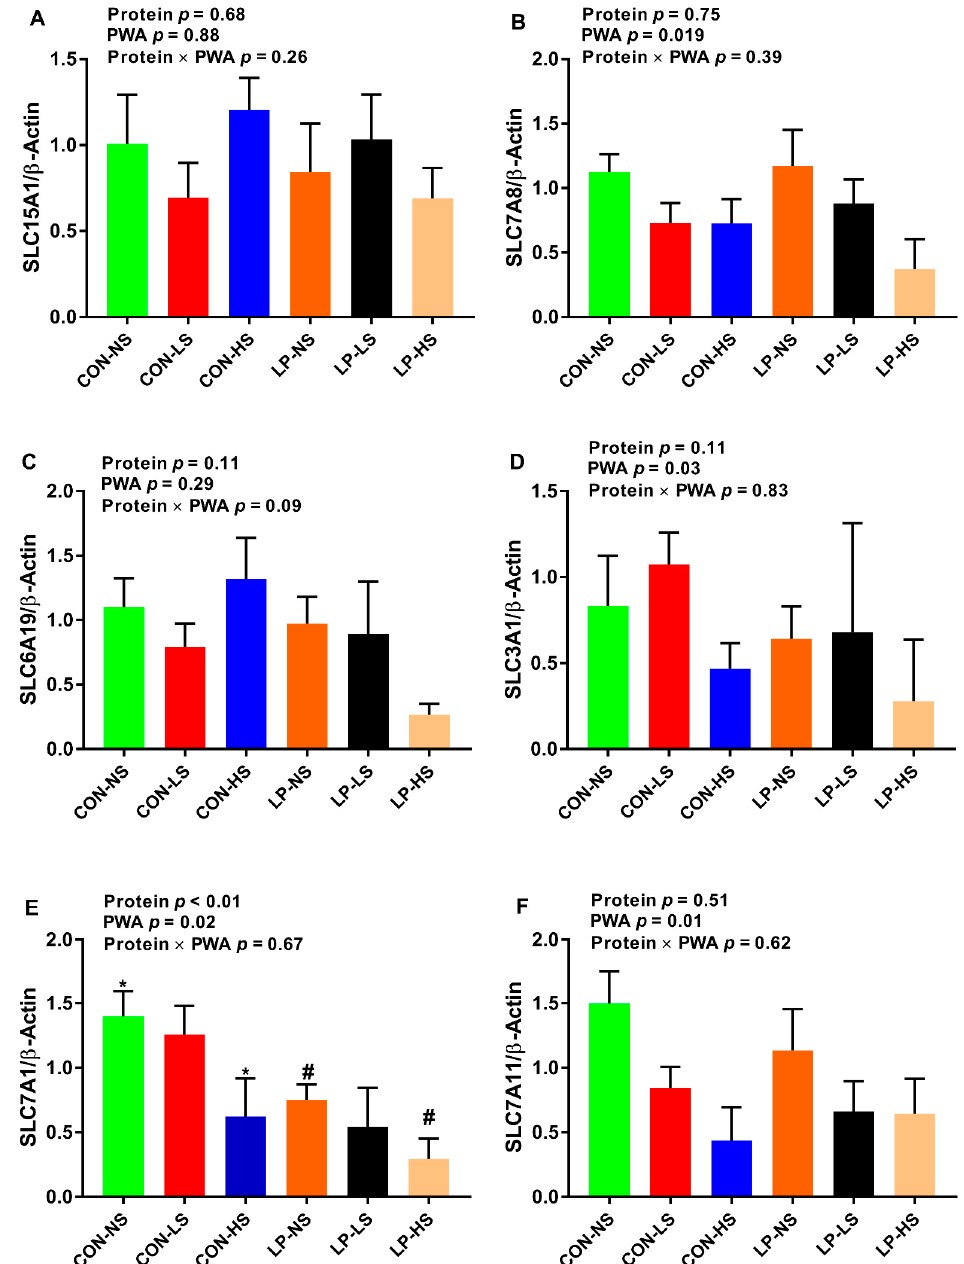
Figure 4. Relative mRNA abundance of ( A ) solute carrier family 15 member 1 ( SLC15A1 ), ( B ) solute carrier family 7 member 8 ( SLC7A8 ), ( C ) solute carrier family 6 member 19 ( SLC6A19 ), ( D ) solute carrier family 3 member 1 ( SLC3A1 ), ( E ) solute carrier family 7, member 1 ( SLC7A1 ), and ( F ) solute carrier family 7 member 11 ( SLC7A11 ) in the skeletal muscle of nursery pigs fed with two levels of dietary protein and three levels of a phytogenic water additive (PWA). CON-NS: control diet with no PWA supplemented, CON-LS: control diet with a low dose of PWA (4 mL/L of water) supplemented, CON-HS: control diet with a high dose of PWA (8 mL/L of water) supplemented, LP-NS: low-protein diet with no PWA added, LP-LS: low-protein diet with a low dose of PWA (4 mL/L of water) added and LP-HS: low-protein diet with a high dose of PWA (8 mL/L of water) added. * # Among groups, values with a common superscript symbol tend to be different (0.05 < p ≤ 0.1). Values are the means ± SEM. n = 8 for each dietary